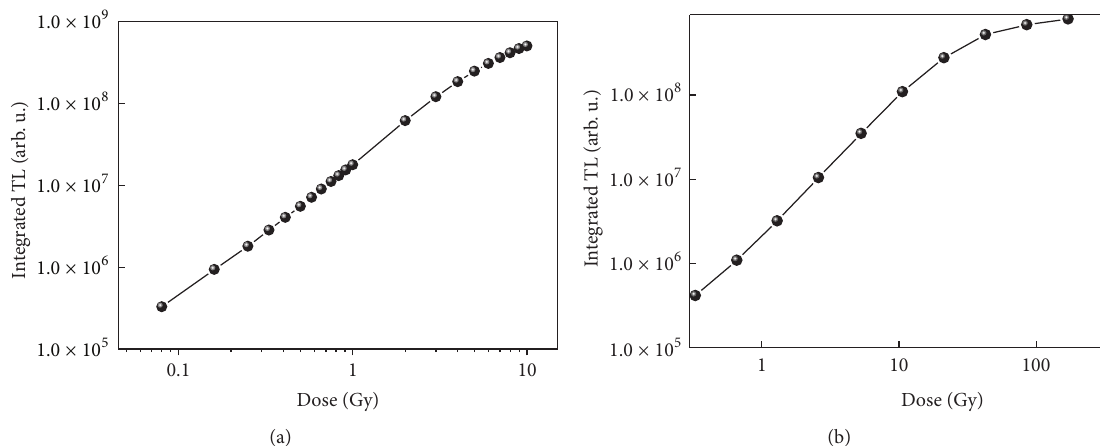
Figure 6: Integrated thermoluminescence as a function of irradiation dose, in the range from (a) 0.08 to 10Gy and (b) up to 170 Gy.